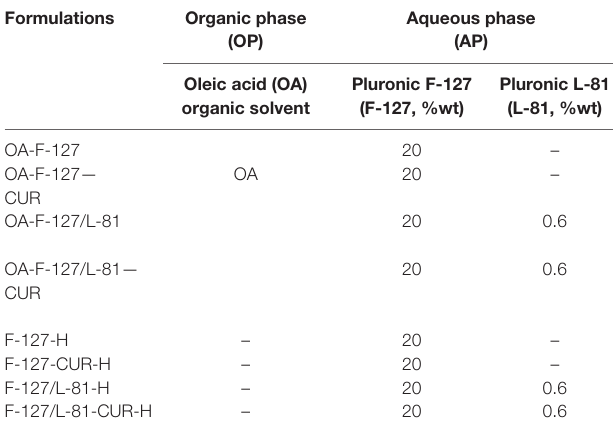
TABLE 1 | Formulations components for different ORG containing curcumin (CUR). Formulations Organic phase